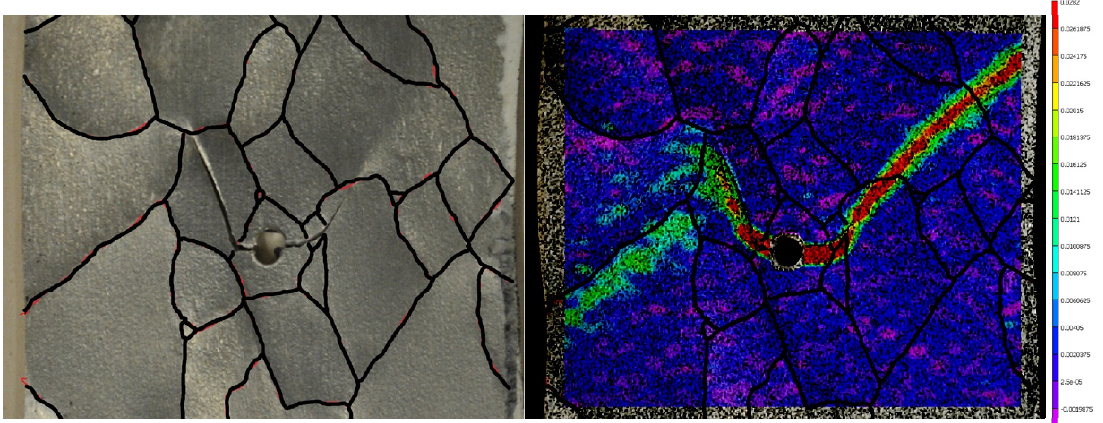
Figure 8: This image shows the DIC analysis and microstructure